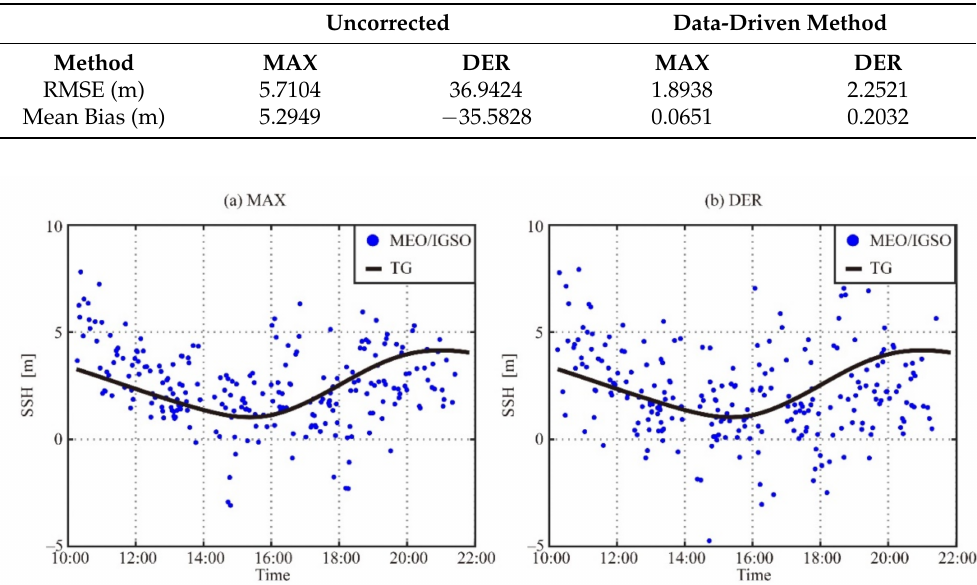
Figure 13. Scatter plot of the ocean altimetry results obtained after correction of elevation angle influence using the data- driven function. ( a , b ) are the height of the coastal receiver relative to the reference surface obtained using BDS MEO/IGSO for different types of characteristic points. Table 3. Altimetry precision obtained using BDS MEO/IGSO for different types of characteris- tic points.